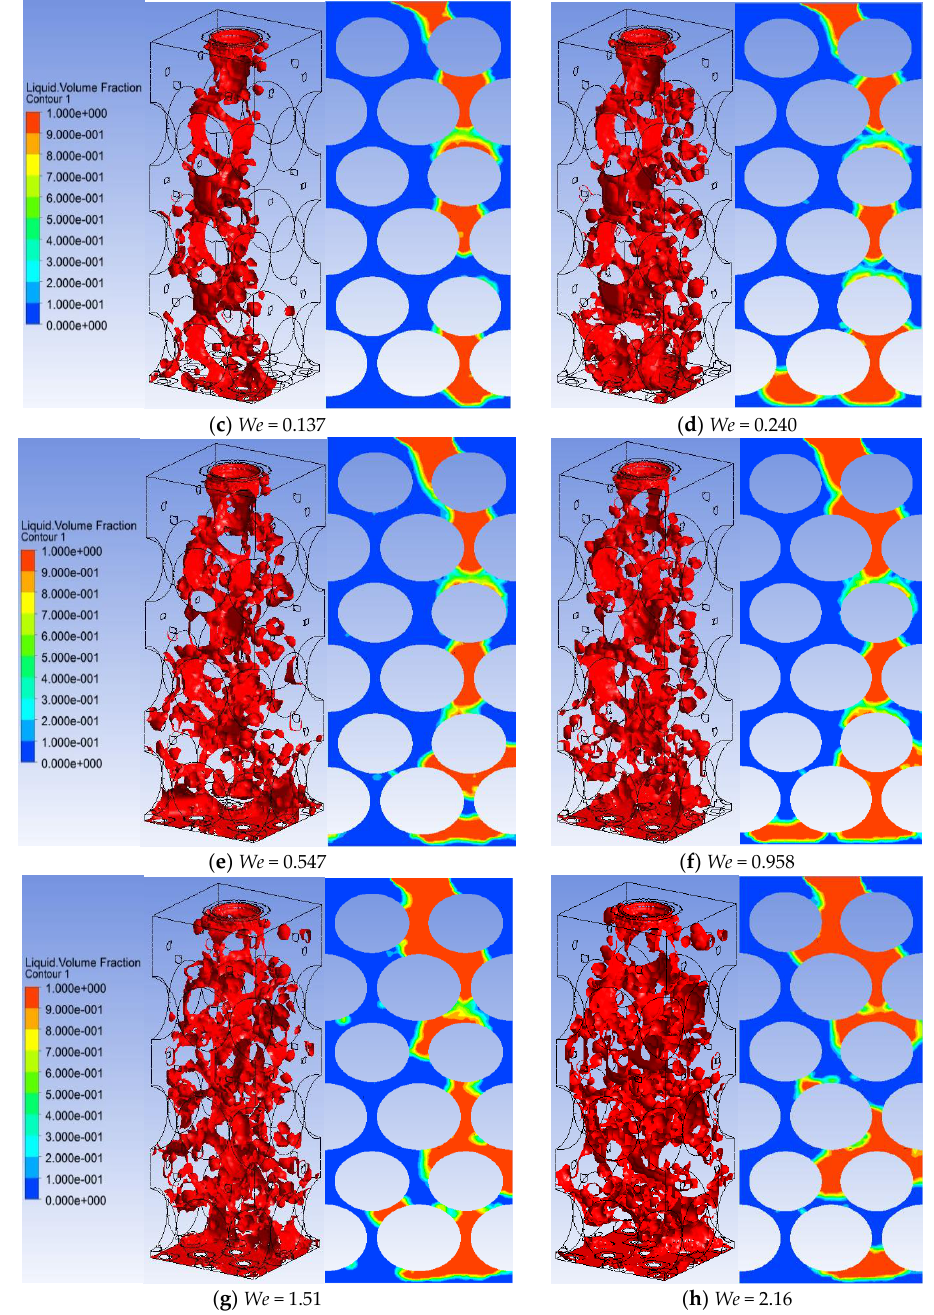
Figure 5. Flow distribution of iso-surface 0 at different liquid We from 0.014 to 2.16 at fixed Re g = 199.